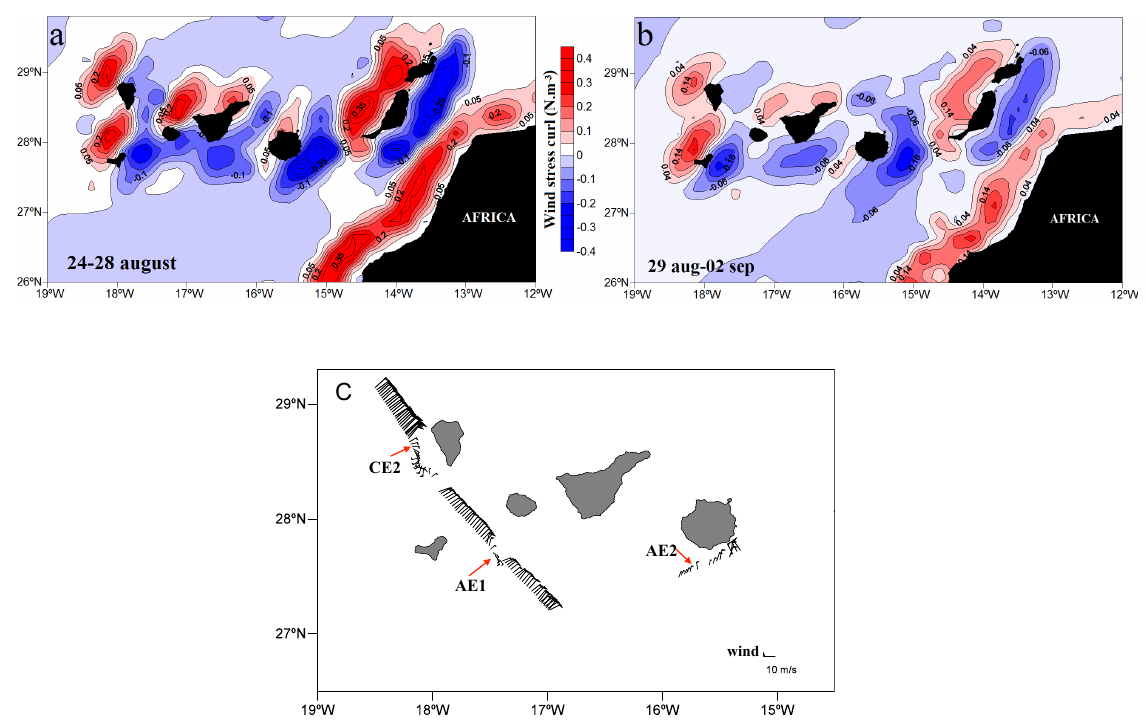
Fig. 4. Five-day-averaged wind curl (a) , (b) and instantaneous wind field from the onboard meteorological station (c)